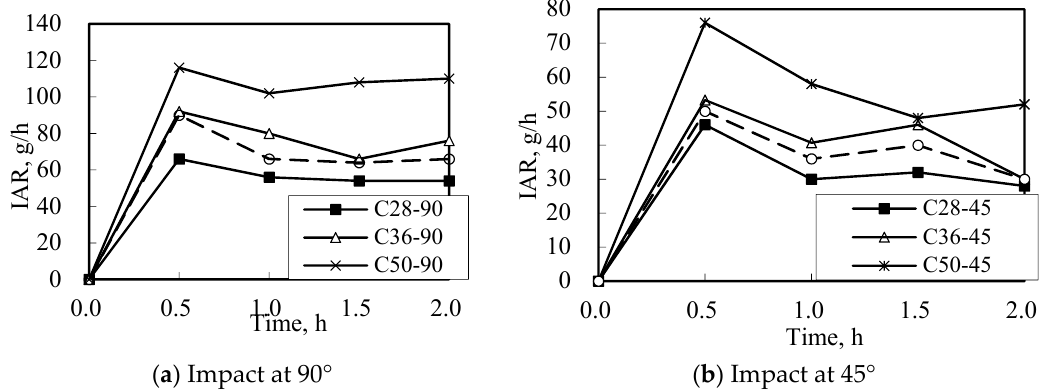
Figure 12. Impact abrasion rate (IAR) of concrete.